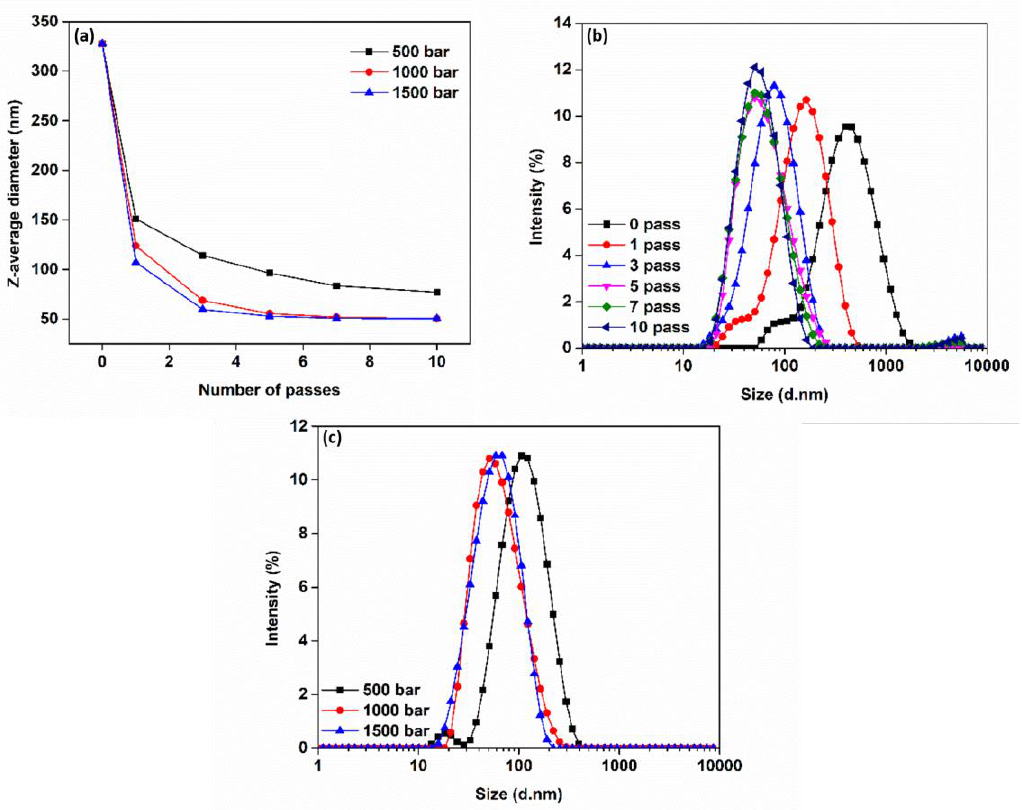
Figure 4. Effect of homogenization pressure and passes on nanoemulsion size: ( a ) average droplet size according to number of pass and pressure, ( b ) size distribution of nanoemulsion at 1000 bar, and ( c ) size distribution of nanoemulsion at 5 passes.